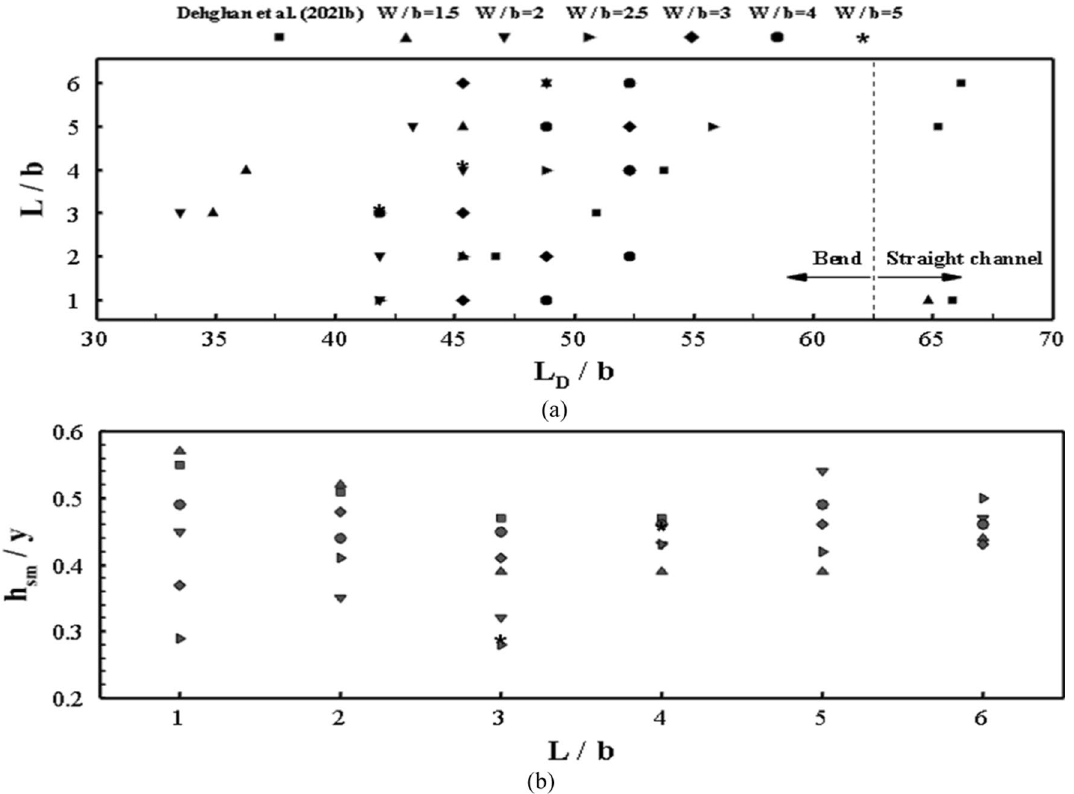
Fig. 10 a Sediment progress toward the downstream straight path and b the maximum sedimentation height when various collars are installed surrounding the